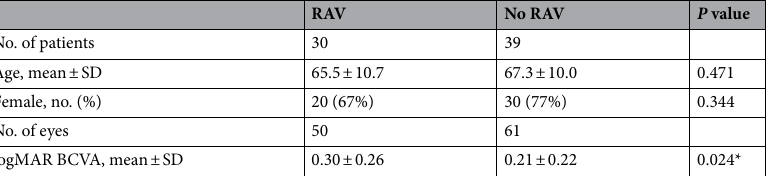
Table 1. Baseline characteristics of included patients according to the presence of right-angled vessel. BCVA best-corrected visual acuity, RAV right-angled vessel, SD standard deviation. *Mean logMAR visual acuity was estimated by using generalized linear models and the generalized estimation equation method to account for the correlation between eyes. P value < 0.05 by generalized linear models and the generalized estimation equation method comparing the presence and absence of right-angled vessel.